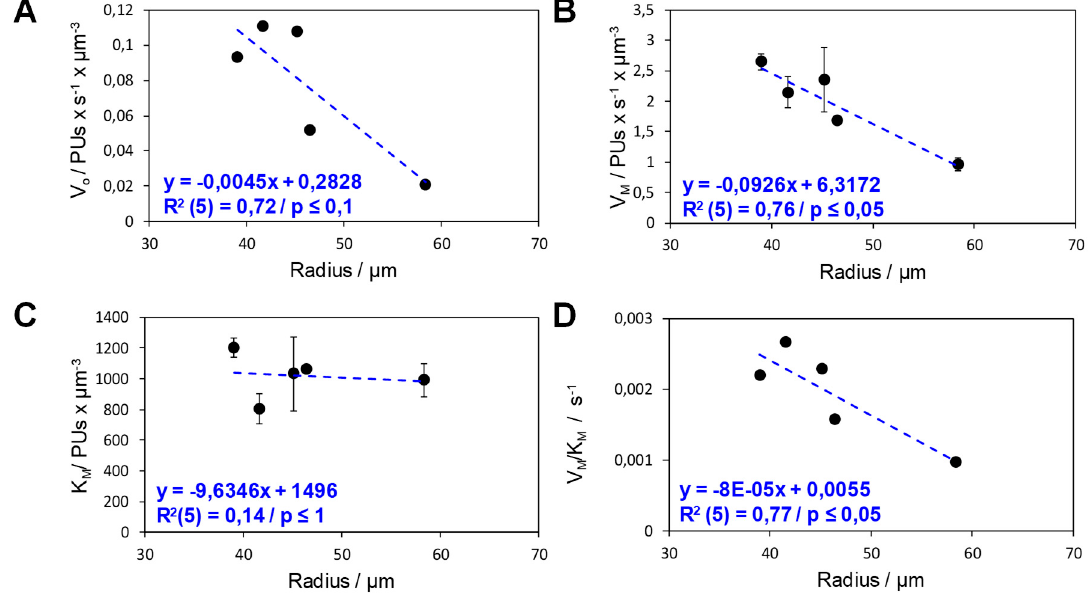
Figure 4. E ff ect of the particle radius on the kinetic parameters of the immobilized KRED and NADPH using TFA as substrate. For single particle analysis, apparent V 0 ( A ), V M ( B ), K M ( C ), and V M / K M ( D ) were determined and plotted against the radius of each particle (circles). Errors for apparent V M and K M values were calculated from three di ff erent iterations of PCAT using di ff erent input data sets. The dashed blue line represents the linear correlation between each kinetic parameter and the particle radius. Linear regression equations are shown within each graph. The correlation coe ffi cients ( R 2 ) and the p -value were calculated with an ANOVA statistical analysis. The regression line and the statics are shown in blue. Number of samples is indicated in brackets beside the R 2 value.